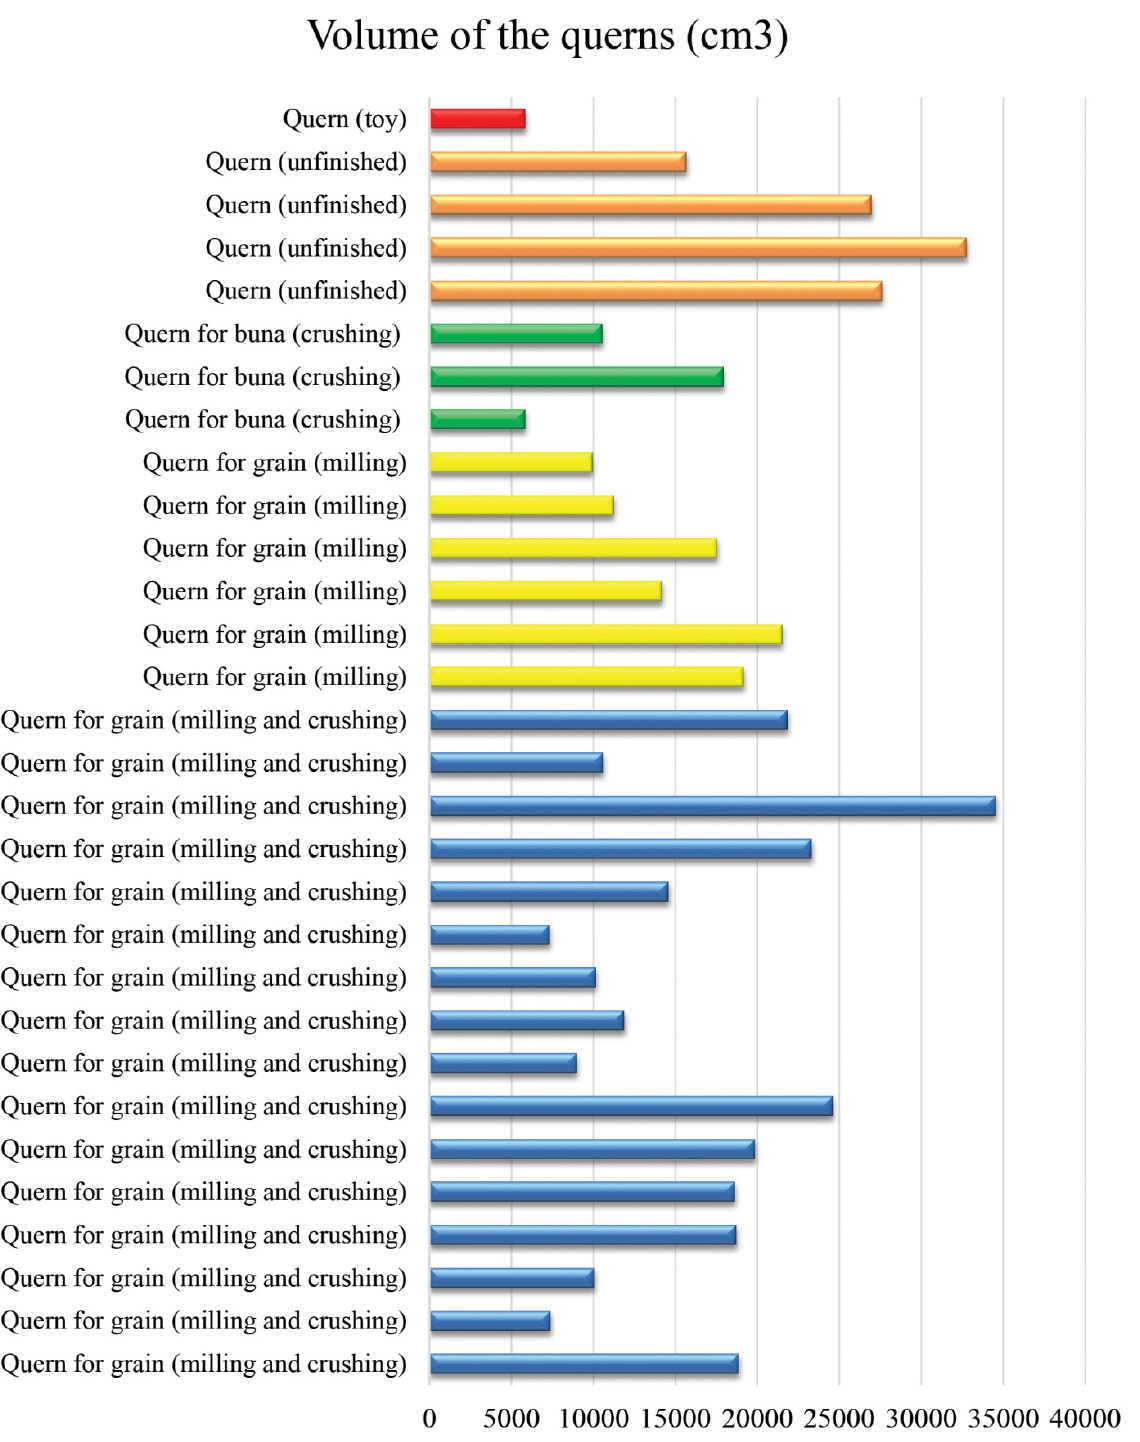
Figure 14. Volumetric characteristics of